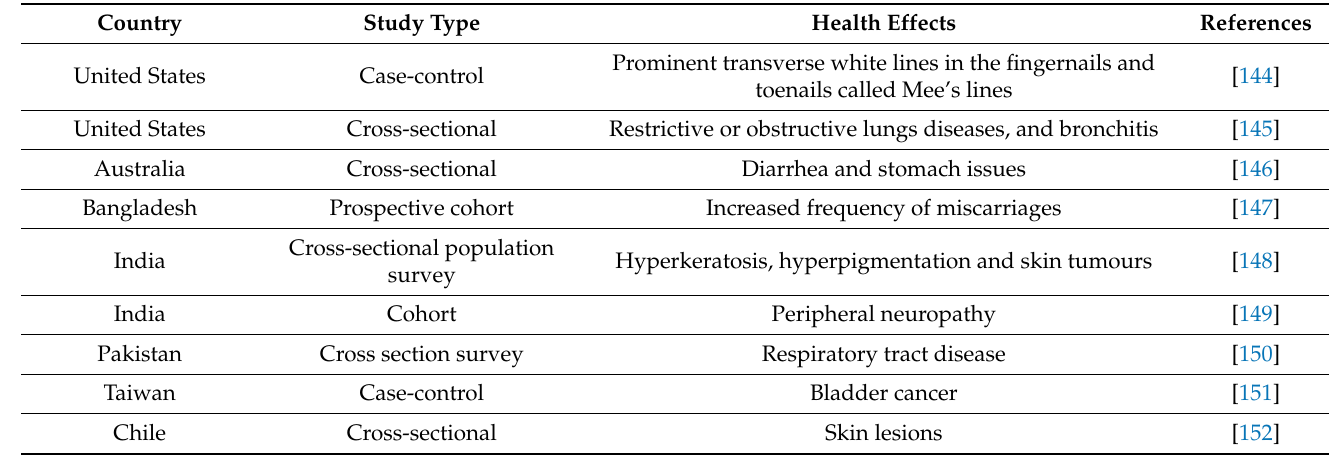
Table 14. Health implications originating from As exposure in different countries